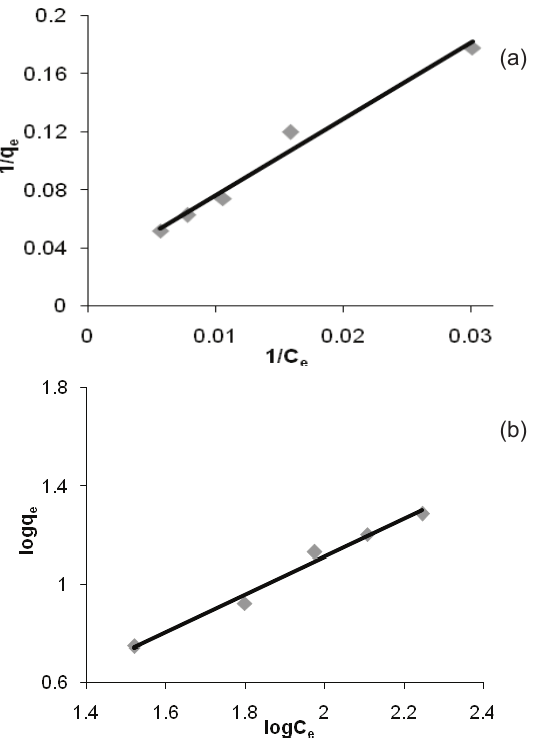
= 300 - 1100 mg L -1 , i